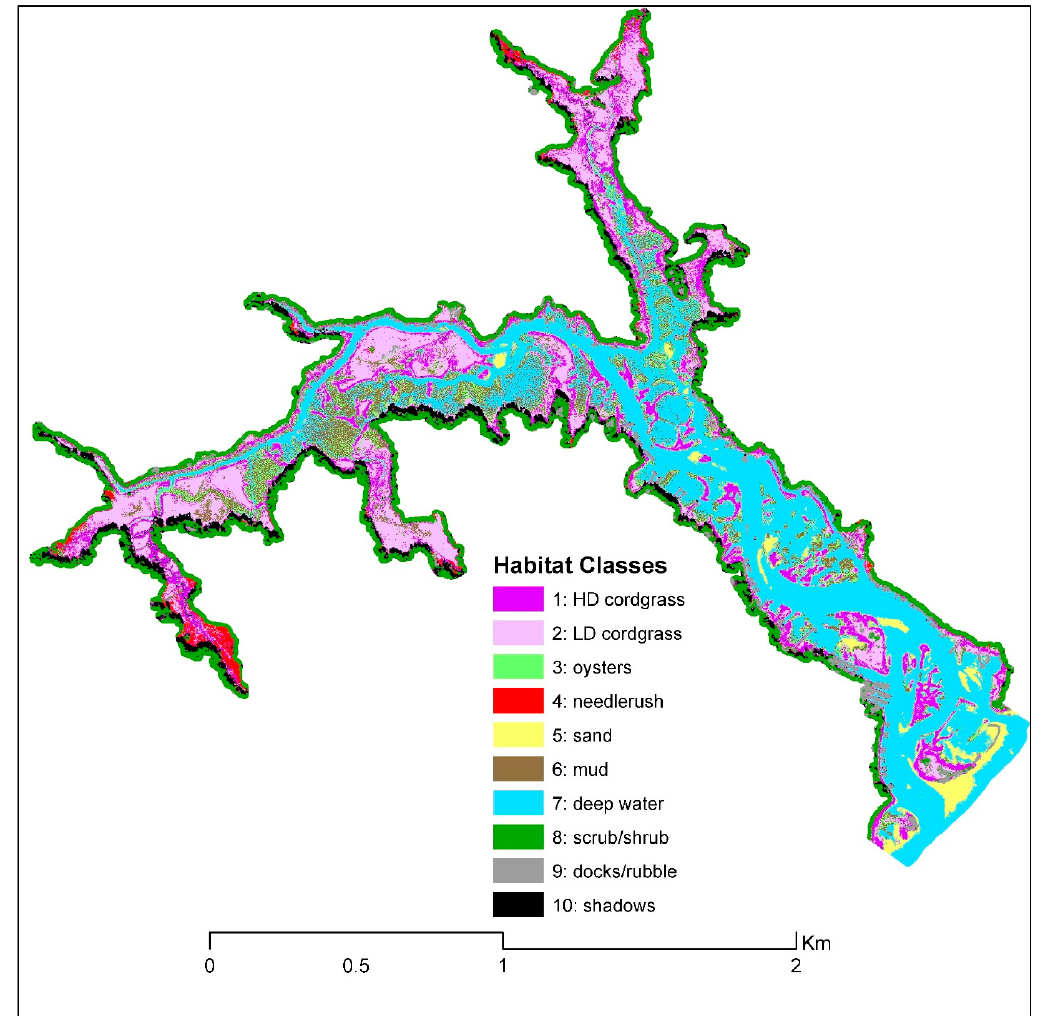
Figure 5. Final habitat classification for the WV-2 image.